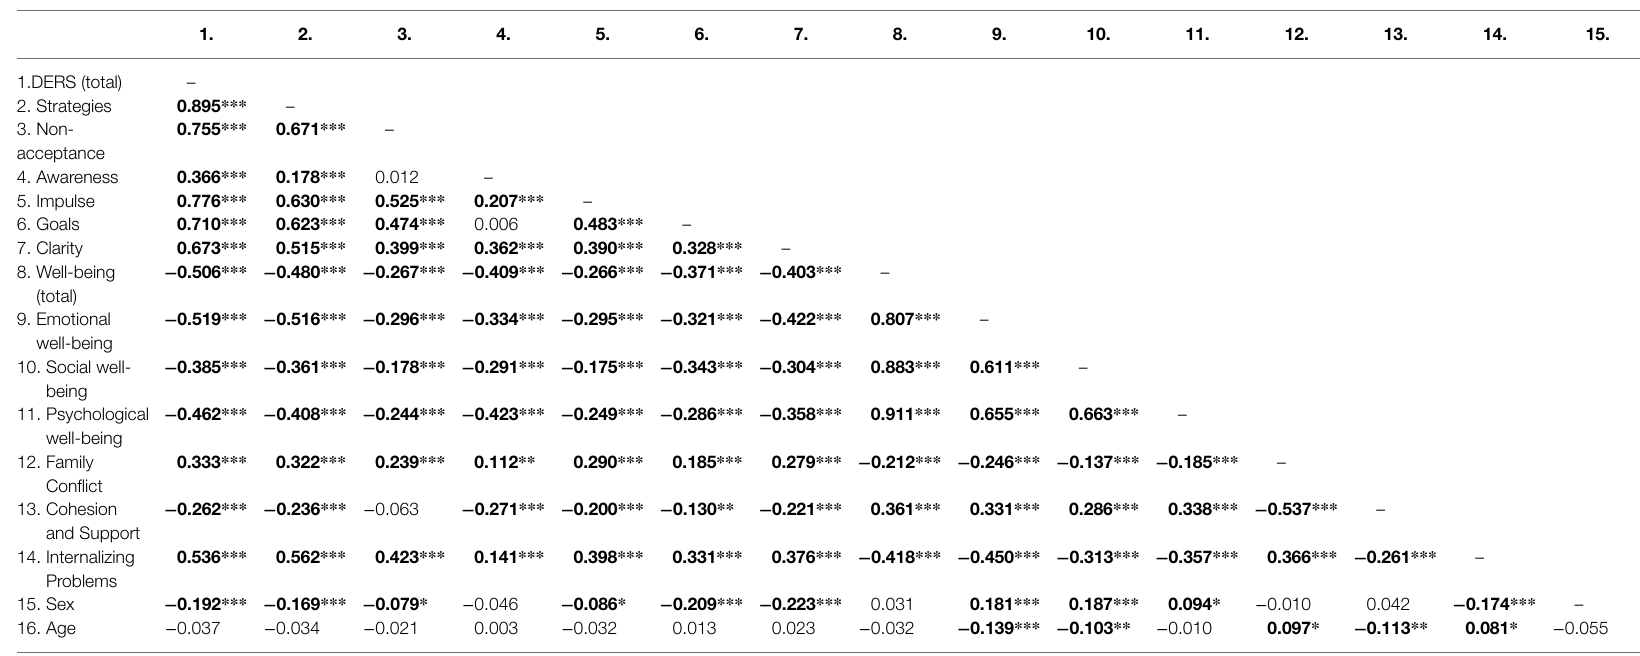
TABLE 1 | Correlations between all variables in study, in all participants ( N =